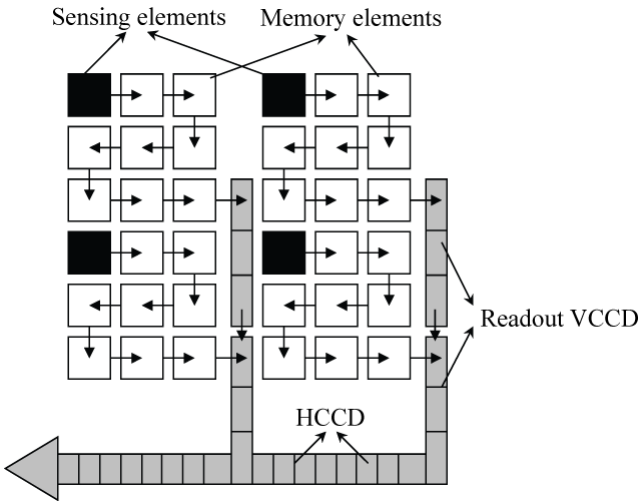
Figure 1. An example of a folded in-pixel CCD memory structure proposed by Elloumi et al.